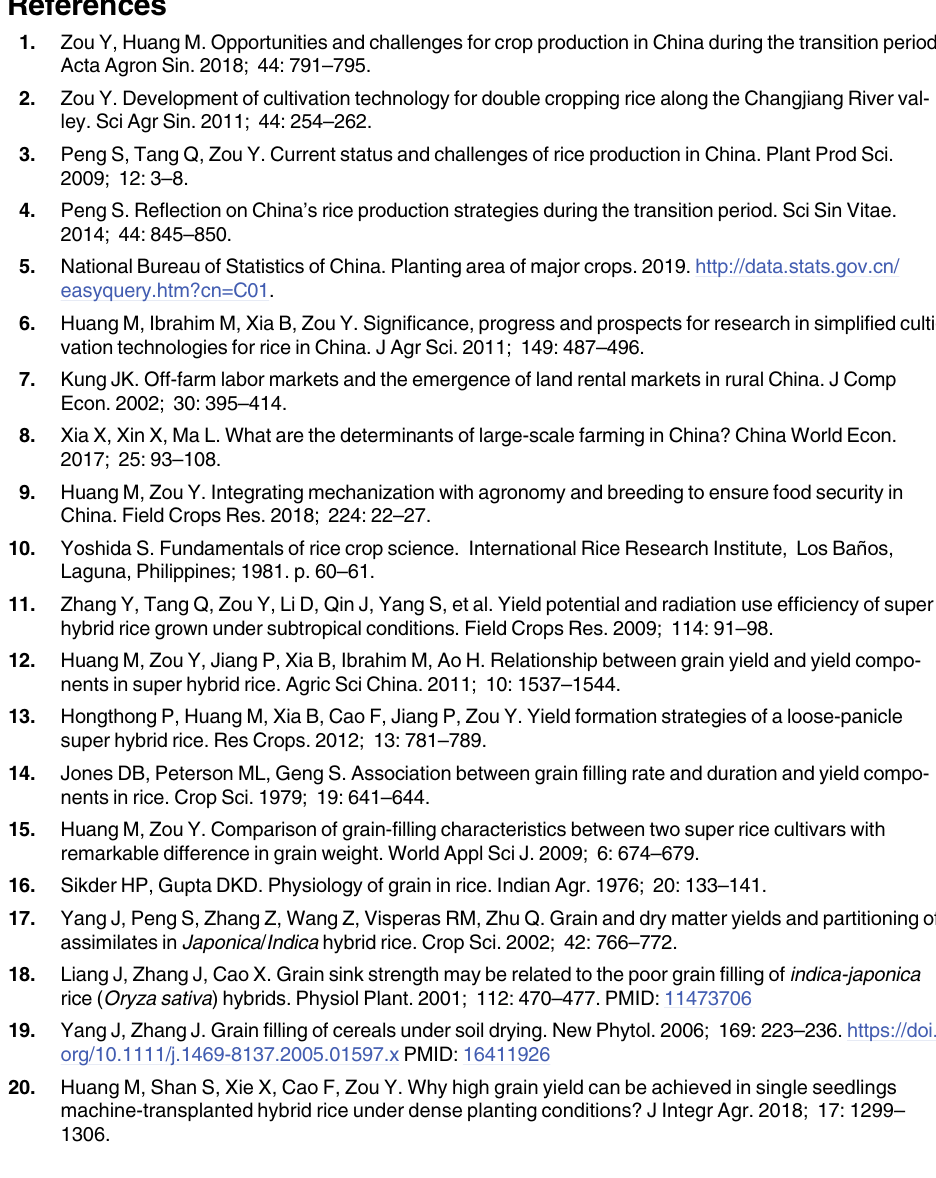
S1 Fig. Relationships between grain yield and yield components in early-season rice. Each point is the mean of three replicates for one cultivar. Error bars show standard